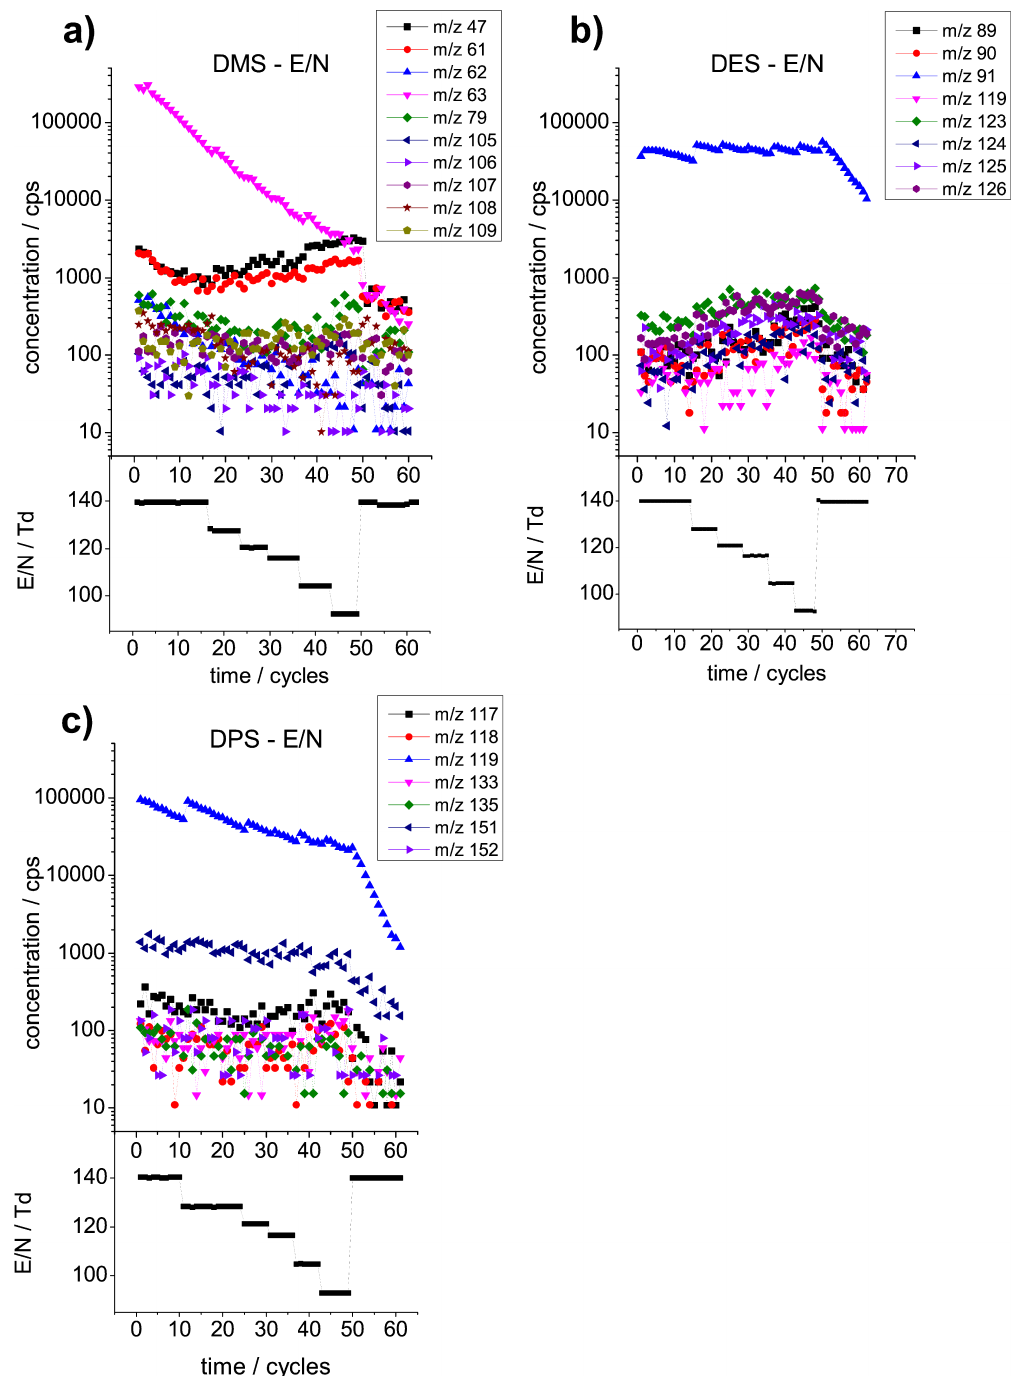
Figure 4. E/N variation study for minor fragment pathways. Studied for (a) DMS (b) DES (c) DPS, dehydrogenation and adduct ion study. MH + is for (a) DMS: m/z 63, (b) DES: m/z 91, (c) DPS: m/z 119. The E/N values at each measurement point are displayed below each plot for the resulting ions. The slopes in log scale are from inert gas stripping for an E/N range varied from , 90–140 The parallel slopes confirm that the fragments are true fragments from the measured sulfides, and hence this proves the existence of dehydrogenation and adduct formation in mono-sulfides. No background correction was performed.